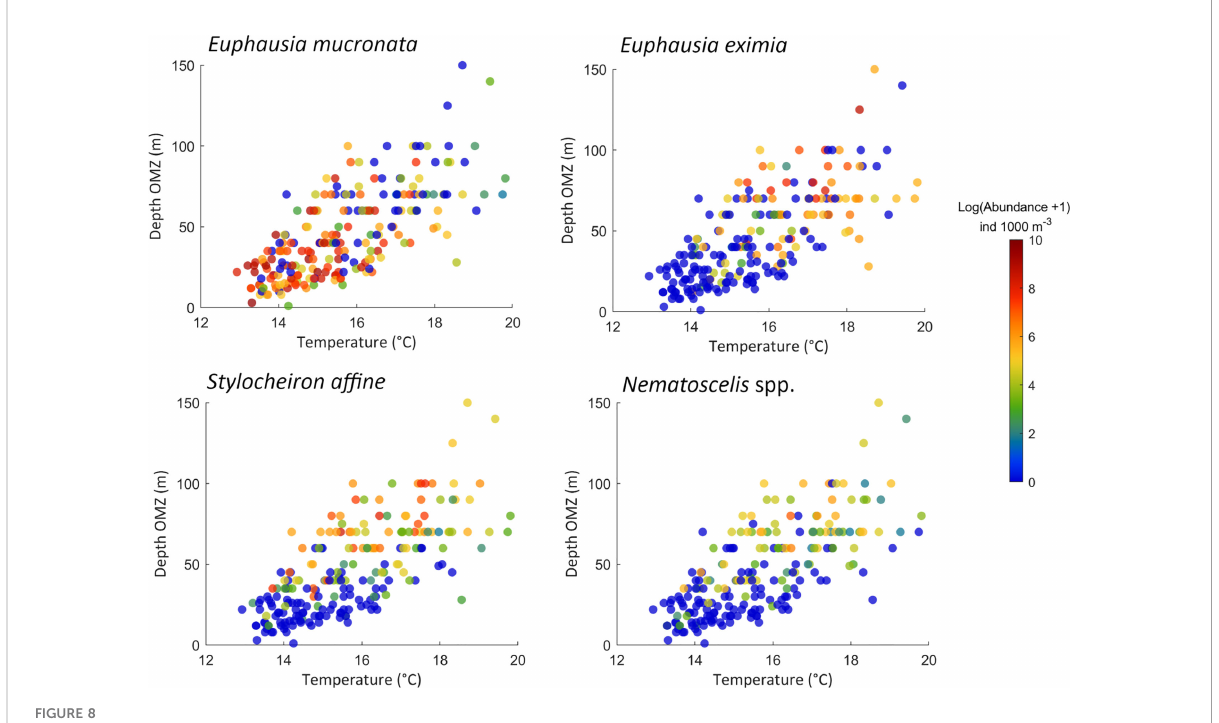
FIGURE 8 MeanTemp/dOMZ diagrams with observed abundances (ind. m -3 )